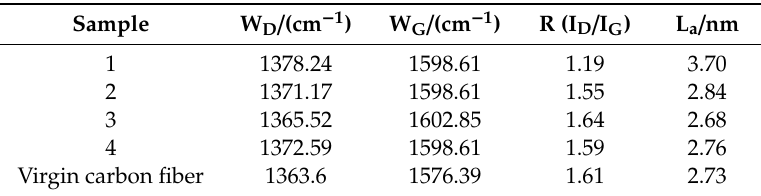
Table 3. Raman results for the recycled carbon